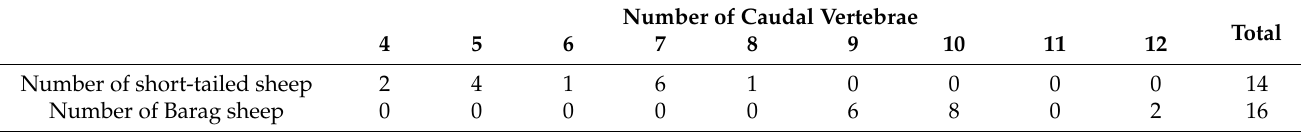
Table 3. Statistics on the number of caudal vertebrae in Barag sheep and short-tailed sheep. Number of Caudal Vertebrae